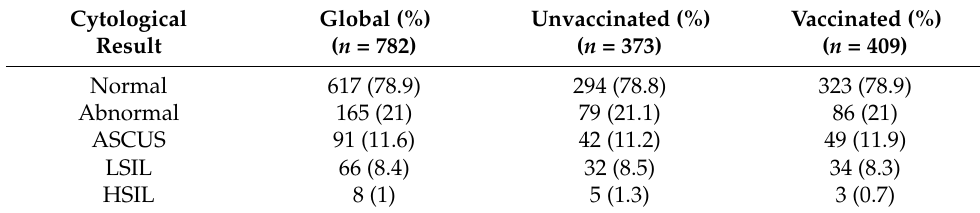
Table 5. Cytological results according to vaccination status.